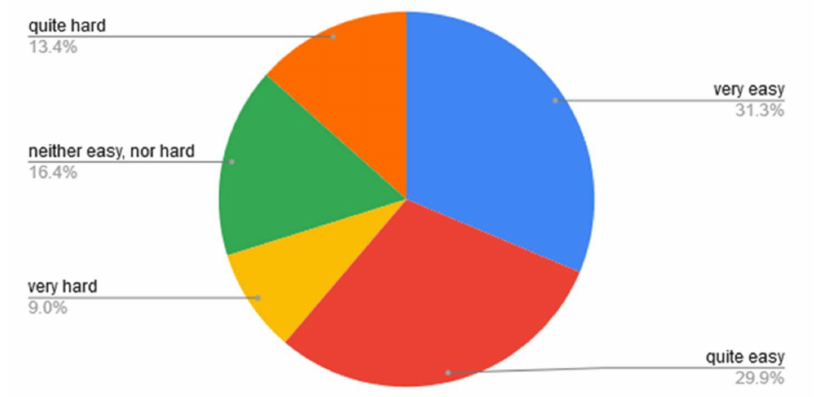
Figure 1. Percentage of how hard it was for the test participants to tell if they were extraverts or